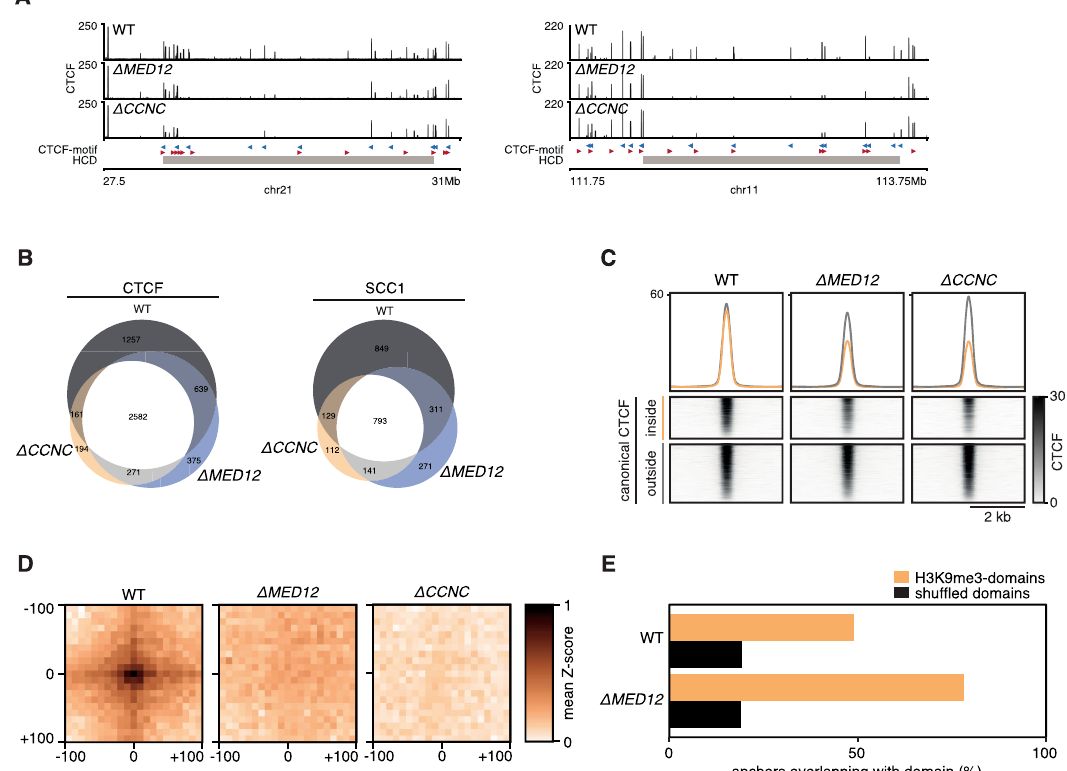
Fig. 4 Mediator-CDK subunits control canonical CTCF-cohesin binding sites. A Two example regions showing CTCF binding in WT, Δ MED12 and Δ CCNC cells. Gray rectangle indicates position of HCD B Venn diagram showing the overlap between CTCF and SCC1 peaks in WT, Δ MED12 and Δ CCNC cells. C Aggregate alignment of CTCF ChIPseq signal on canonical (i.e. CTCF/SCC1 co-bound sites) strati fi ed for inside and outside a H3K9me3 domain. D Virtual loop anchorpoints were selected as intersection of CTCF and SCC1 sites that were in the top 10% with the strongest decrease in signal. Pairwise alignment of Hi-C signal (PE-SCAn) on virtual anchorpoints. E Relative enrichment of lost virtual anchorpoints inside H3K9Me3 domains versus expected based on circular permutation (shuf fl